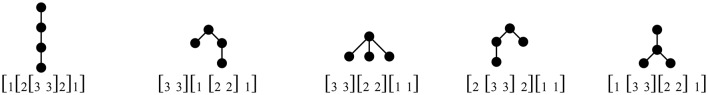
Brackets, and corresponding push-pop trees, for accepted (stack-sortable) orders of three elements. These are simply the Dyck trees with 4 nodes.